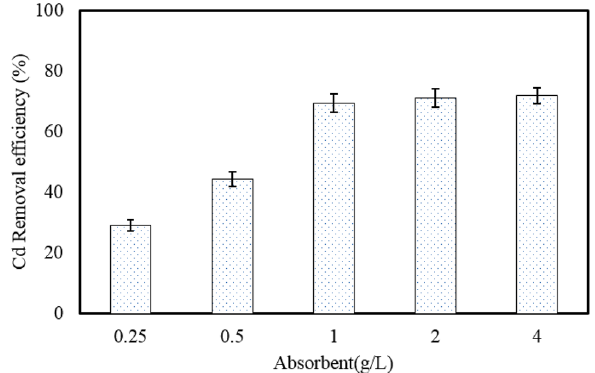
Figure 8. The effect of dosage of adsorbent on the removal efficiency of Cd(II) by MBA nano-hybrid (C 0 = 40 mg/L, pH = 7.0, temperature = 25 °C, time = 60